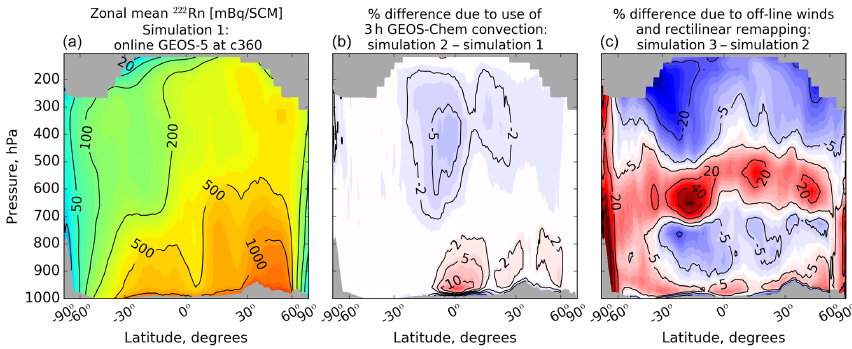
Figure 2. Off-line transport errors in 222 Rn concentrations simulated at c360 ( ≈ 25km) resolution. (a) Zonal mean concentrations of 222 Rn from the online GEOS-5 reference simulation with c360 cubed-sphere resolution (simulation 1). Values are monthly means for July 2013 after a 1-month spin-up from zero concentrations and are expressed in mixing ratio units of millibecquerels per standard cubic meter (at 0 ◦ C and 1atm pressure) or mBq SCM − 1 . (b) Errors due to the use of simplified off-line GEOS-Chem convection shown as percentage differences between simulation 2 and simulation 1. (c) Errors in the high-resolution GEOS-Chem simulation at 0.25 ◦ × 0.3125 ◦ ( ≈ 25km) resolution due to off-line archiving of winds and mixing depths, remapping to rectilinear grid, and use of different transport schemes shown as percentage differences between simulation 3 and simulation 2. The abscissa is on a sine latitude (equal area) scale. Stratospheric results are not shown (see text). Here and in other figures, solid color contours provide finer gradation of the labeled line